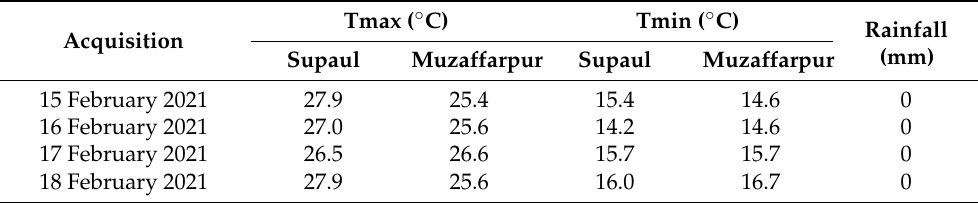
Table 2. Weather conditions during the field campaign as per the IMD station located in Supaul and Muzaffarpur. Across all stations, there were no wet days recorded during this period and in the previous